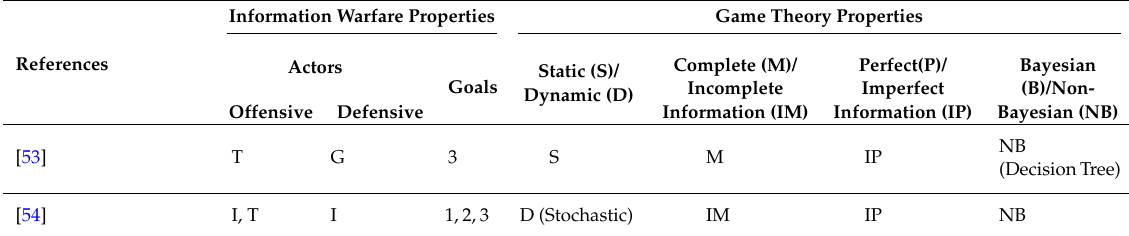
Table 5. List of Psychological Warfare